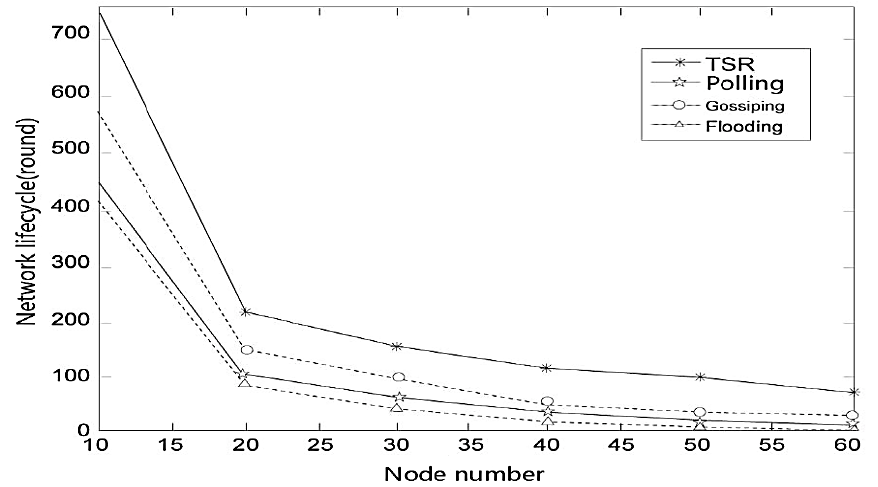
Figure 7. The network lifecycle under different node